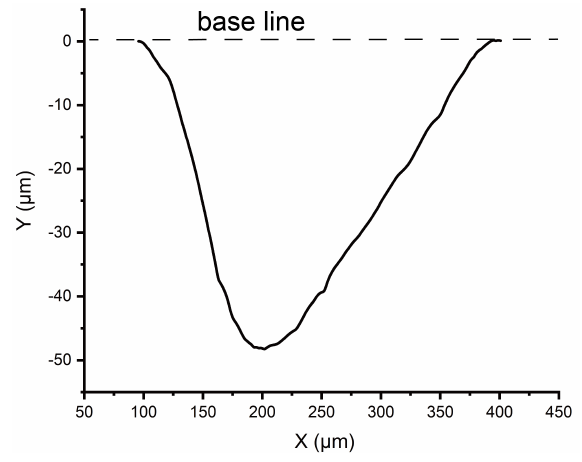
Figure A3. Profile of a micro groove on OSTE.